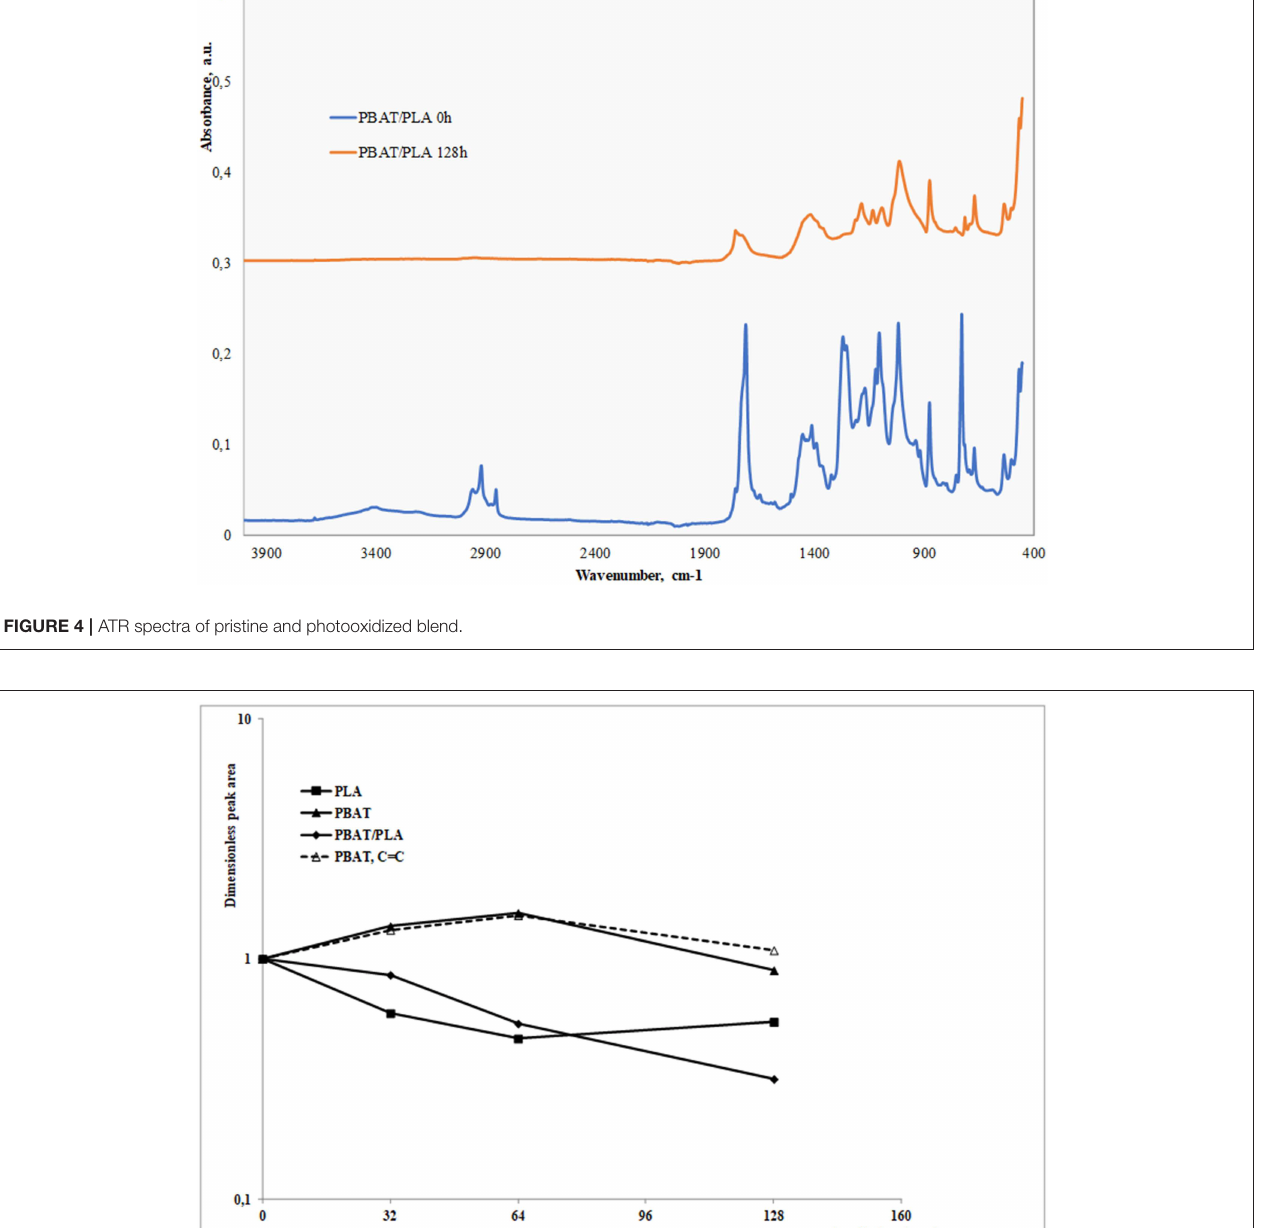
Frontiers in Materials |